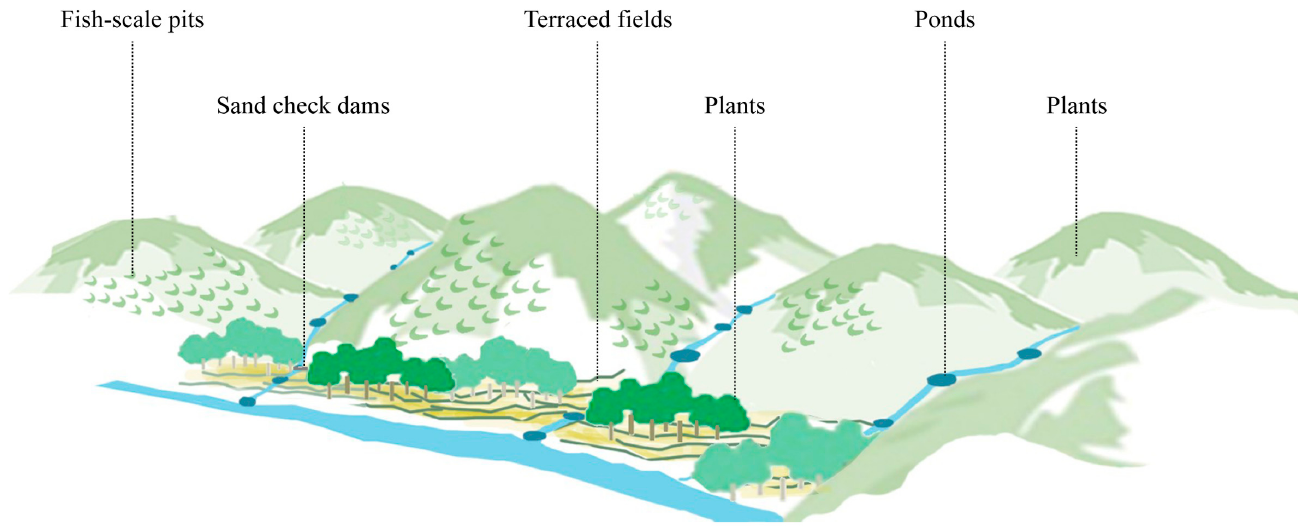
Figure 2. Source-focused strategies include digging fish-scale pits and planting trees on steep slopes, constructing terraced fields on gentle slopes, building sand check dams in the foothills, constructing ponds and earthen benches in low-lying areas, and so on.